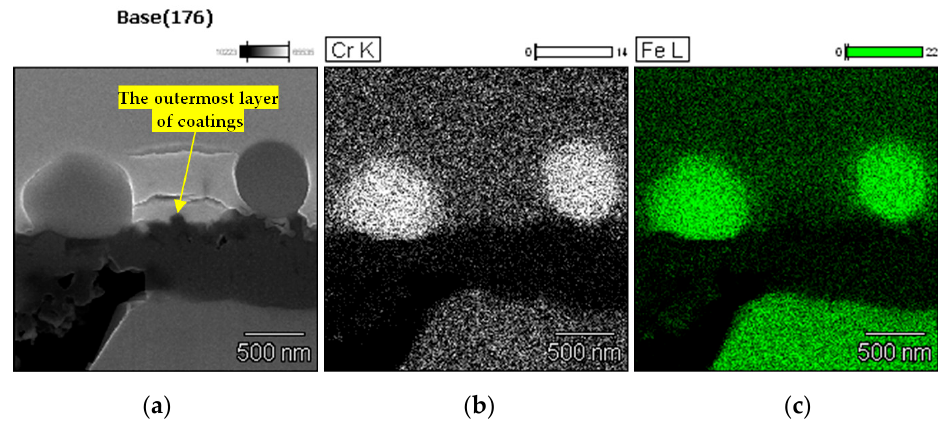
Figure 7. The microstructure and chemical composition of the particles revealed on the surface of the